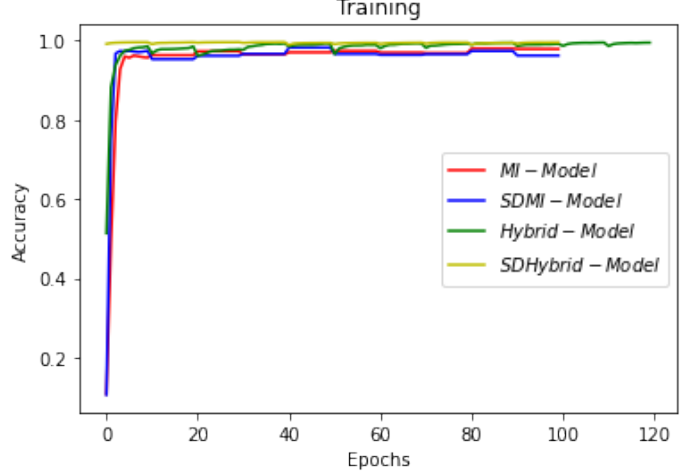
Figure 21. Comparison of Training Accuracy.